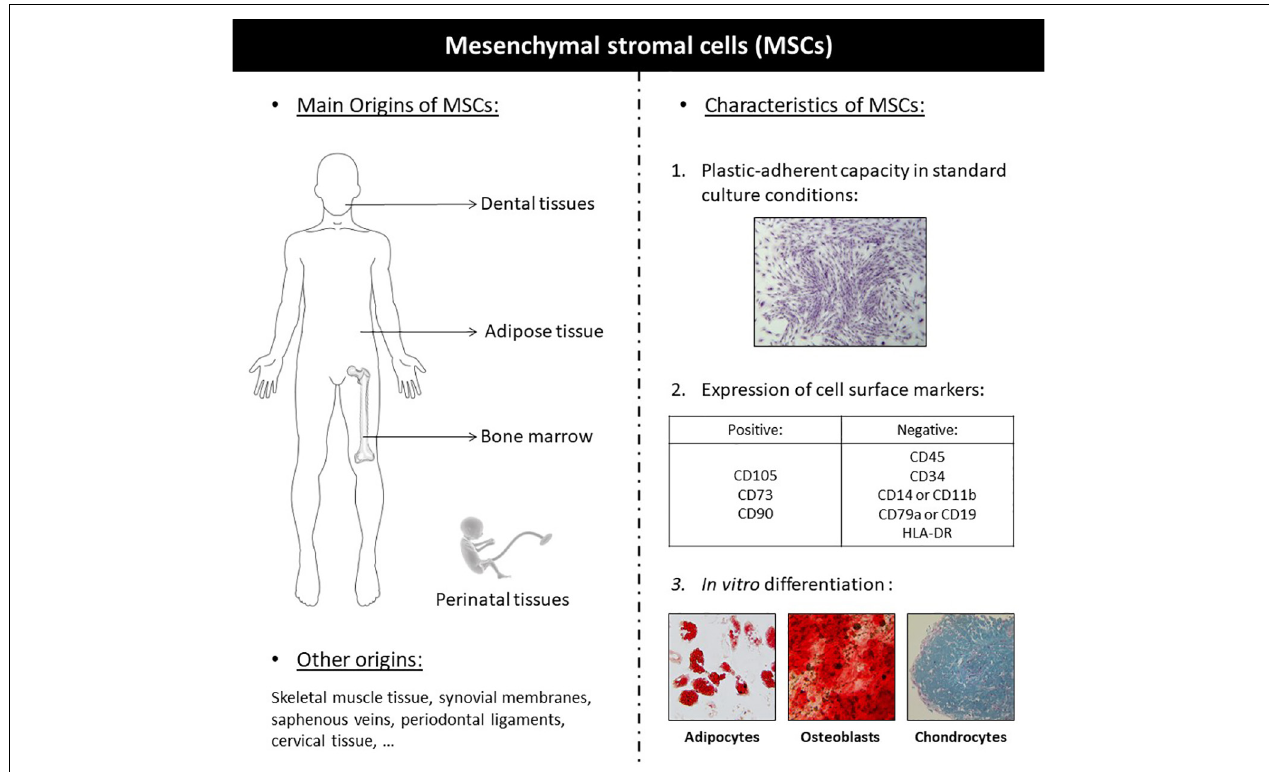
FIGURE 1 | Definition and illustration of the different sources of mesenchymal stromal